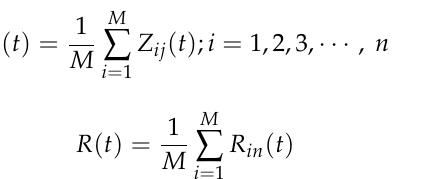
Figure 4. Structure of chained deep learning LSTM blocks and their symbols/notations. The equation below illustrates the calculation processes involved in DL-LSTM NNs. (a) Forget gate equation: ℱ (cid:3047) = 𝜎(cid:3435)𝑊 (cid:3033) × (cid:4670)ℎ (cid:3047)(cid:2879)(cid:2869) , 𝑥 (cid:3047) (cid:4671) + 𝑏 (cid:3033) (cid:3439)